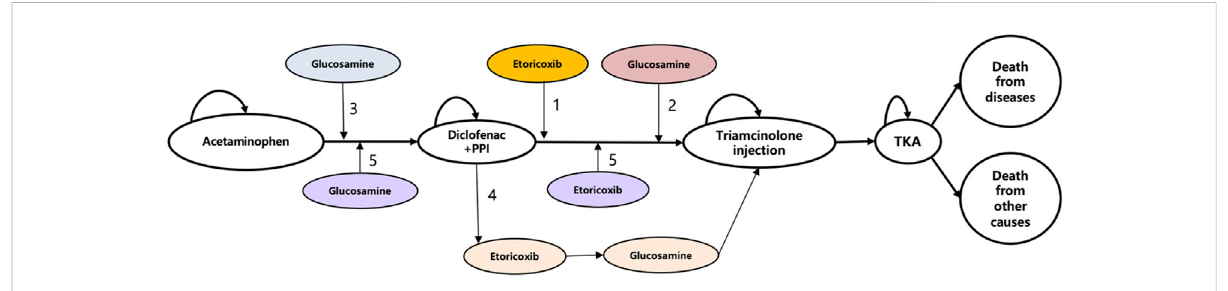
FIGURE 1 Model structure. PPI, proton pump inhibitors; TKA, total knee